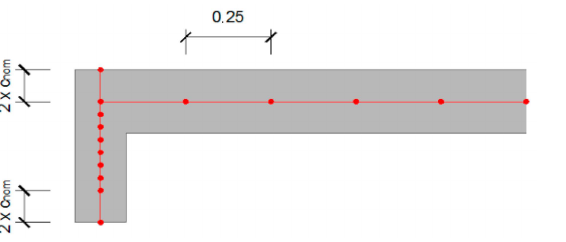
Figure 16. Connection scheme for slab with the beam in the finite element model.